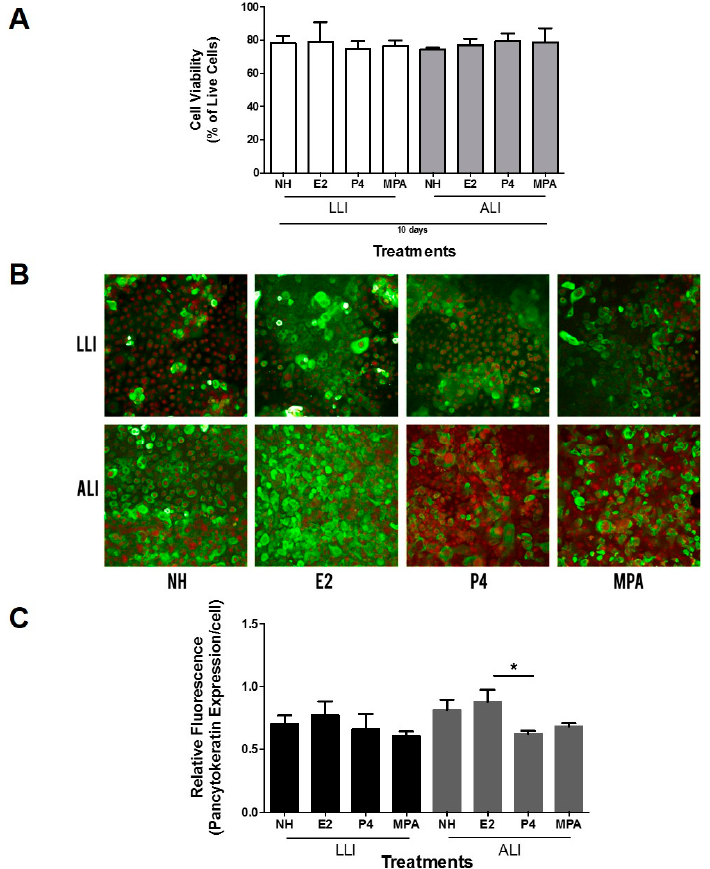
Figure 3. Cytokeratin staining comparison between the LLI and ALI of Vk2 cells after treatment with female sex hormones and medroxyprogesterone acetate (MPA). ( A ) Vk2 cells grown to confluence for 10 days were exposed to no hormone (NH), estradiol (E2; 10 − 9 M), progesterone (P4; 10 − 7 M), and medroxyprogesterone acetate (MPA; 10 − 9 M). Cell viability was measured using the trypan blue assay and expressed as percent of live cells in culture; ( B ) Pancytokeratin staining, green fluorescence, was done using mouse anti ‐ human monoclonal anti ‐ pan cytokeratin antibody. Propidium iodide was used for nuclear counter ‐ staining, red fluorescence. All samples were imaged on an inverted confocal laser ‐ scanning microscope. Representative images are shown. Images were taken in the X , Y plane; ( C ) Relative fluorescence of cytokeratin (green) to nuclear stain (red) was measured to quantify the amount of cytokeratin present per cell. Data shown represent mean ± standard error of the mean (SEM) of three separate cultures. * p < 0.05. Three replicates per experimental condition were included for each experiment. Magnification 20×.